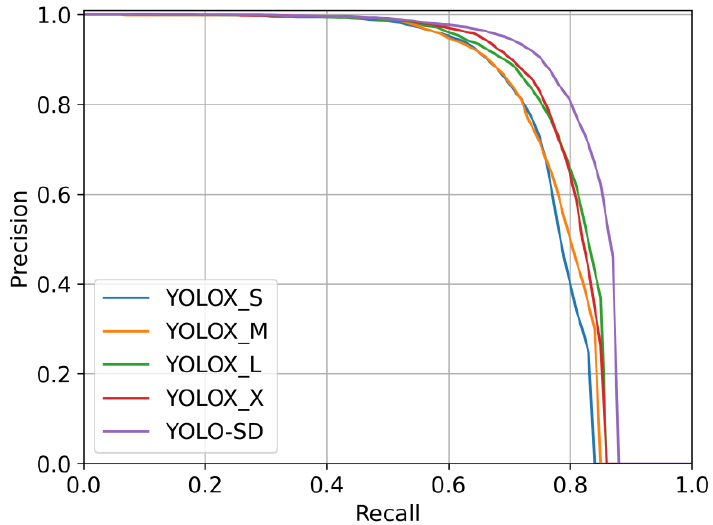
Figure 7. Comparison of the P-R curves of YOLOX with different complexity.